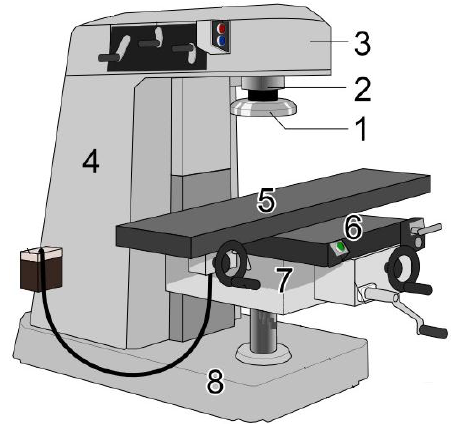
Figure 1. Vertical milling machine: (1) milling cutter; (2) spindle; (3) top slide or over arm; (4) column; (5) table; (6) Y-axis slide; (7) knee; and (8) base.